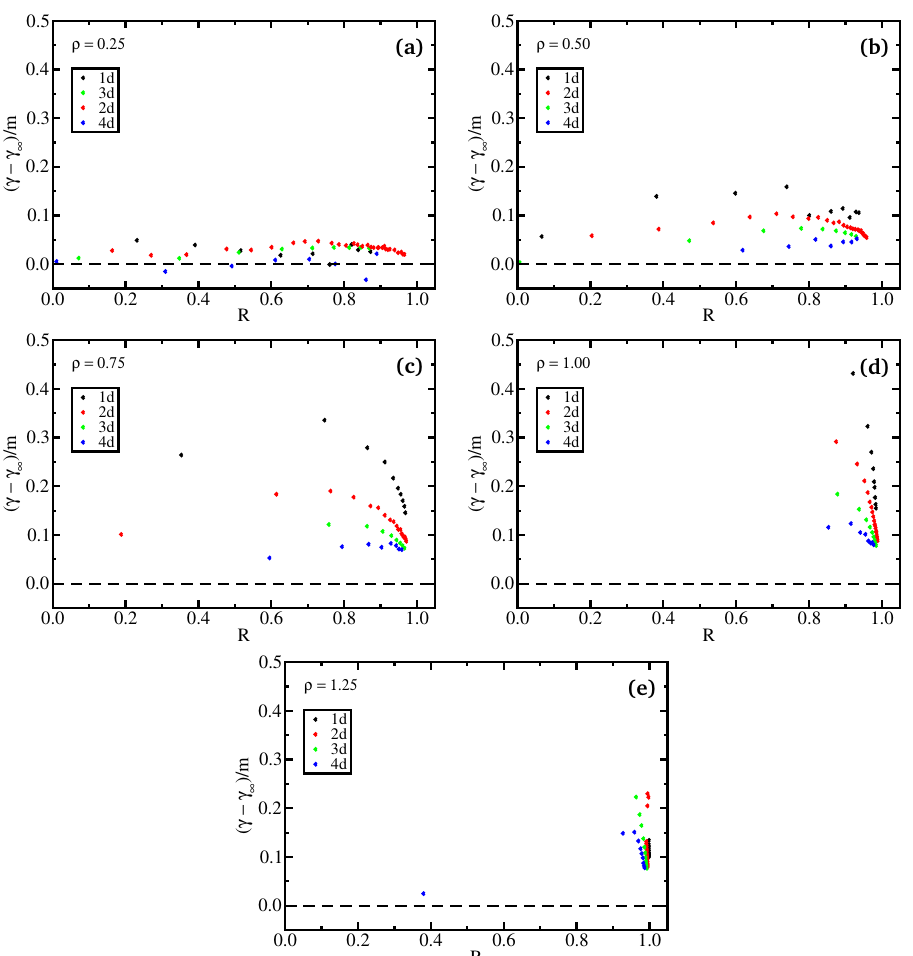
Figure 5: Relative deviations from the d → ∞ value of the ( R , γ ) curves of the LJ ( 4 d ,2 d ) systems for dimensions d = 1 to 4. In each plot we have subtracted the d → ∞ curve obtained in Eq. (13), γ ∞ ( R ) , from the simulation data γ by m ( = 4). The horizontal dashed line at the origin of the vertical axis corresponds to the exact d → ∞ curve. Each plot from (a) to (e) is given for a fixed isochore with density varying from ρ = 0.25 to 1.25 in steps of 0.25. The higher the density, the closer are state points from the R = 1 boundary. Simulation data before subtraction are displayed in Fig. 3. The value of γ estimated from Eq. (13) is a lower bound to the actual value found from simulations, at least away from the low-density limit where Eq.(13) becomes